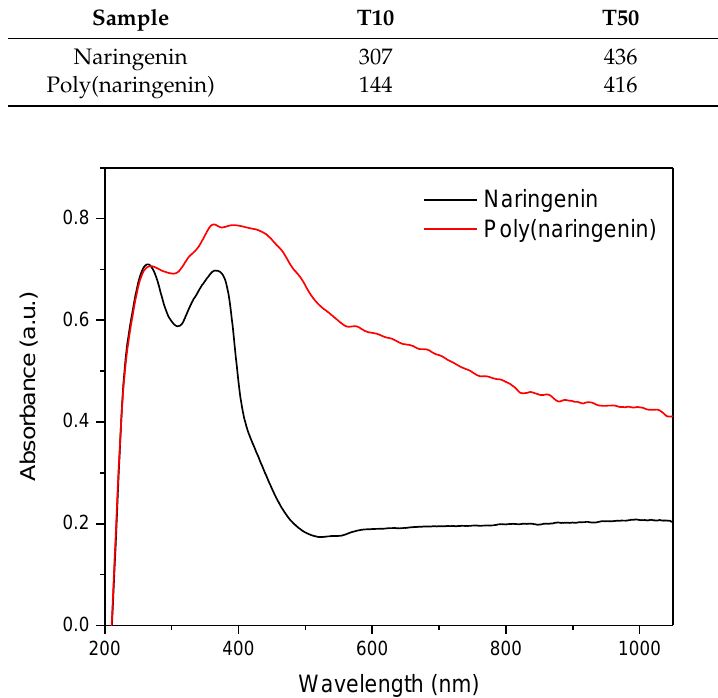
Figure 6. UV-Vis spectra of naringenin and poly(naringenin) powders. In the next stage of research, the thermal properties of naringenin and poly(naringenin) were investigated. The thermal stability of monomeric and polymeric forms of the flavonoid were established using thermogravimetry, TG. The results of the examinations are shown in Figure 7 and Table 1.